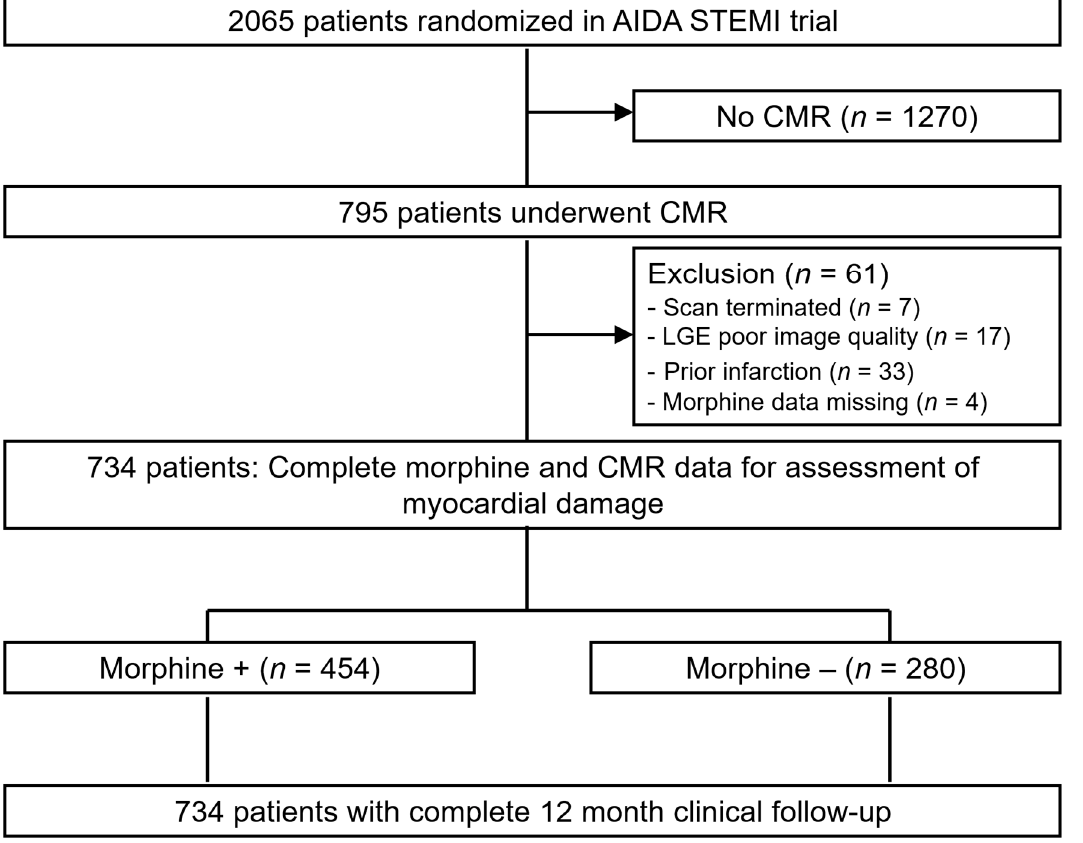
Figure 1. Study Flow. This study was a predefined sub-study of the AIDA STEMI trial (Abciximab Intracoronary Versus Intravenously Drug Application in STEMI). CMR = cardiac magnetic resonance, LGE = late gadolinium enhancement.